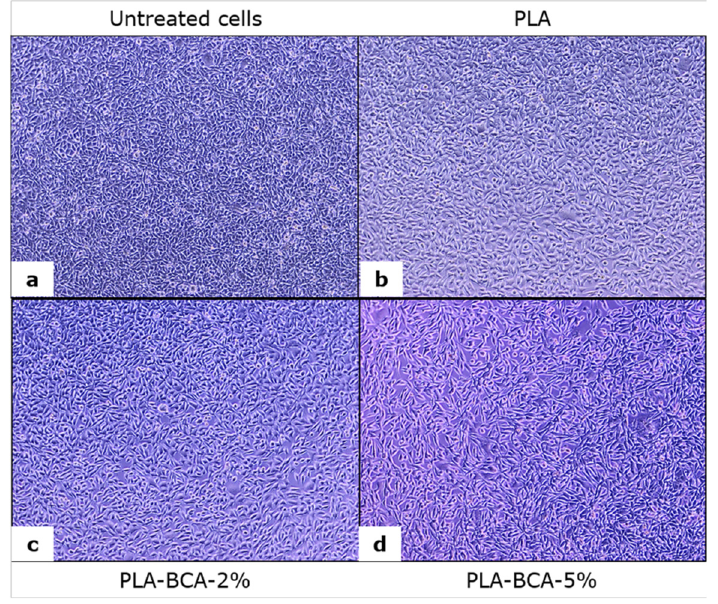
Figure 8. L929 cells after three days of incubation with standard cell culture medium (untreated cells) without electrospun fibers ( a ), with PLA ( b ), PLA-BCA-2% ( c ), and PLA-BCA-5% ( d ) electro- spun fibers.